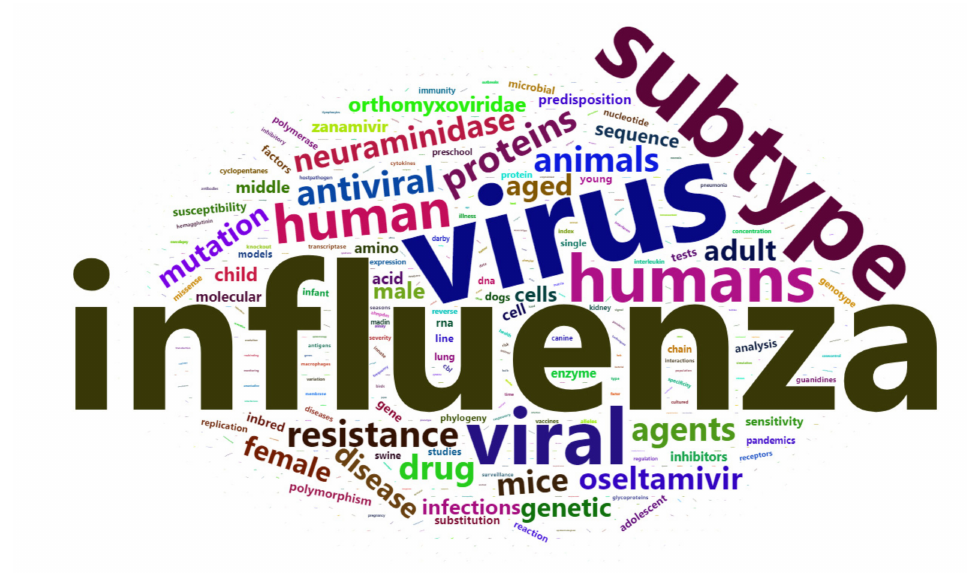
Figure 2. Depicting word cloud showing main keywords in the bibliometric